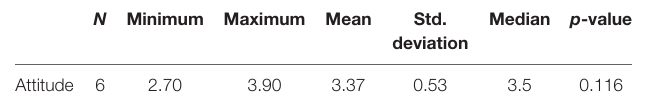
Median p -value deviation